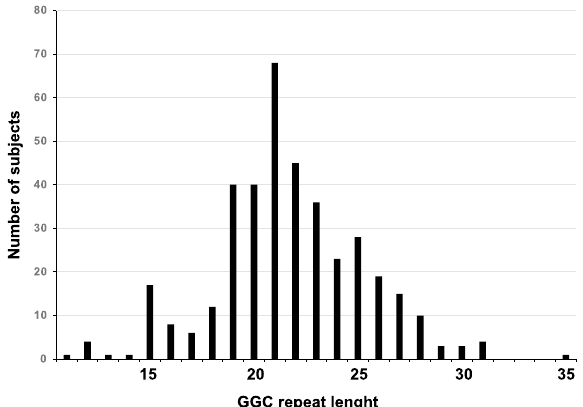
Figure 1. Distribution of the GGC repeat length of NOTCH2NLC in the 385 Italian patients with amyotrophic lateral